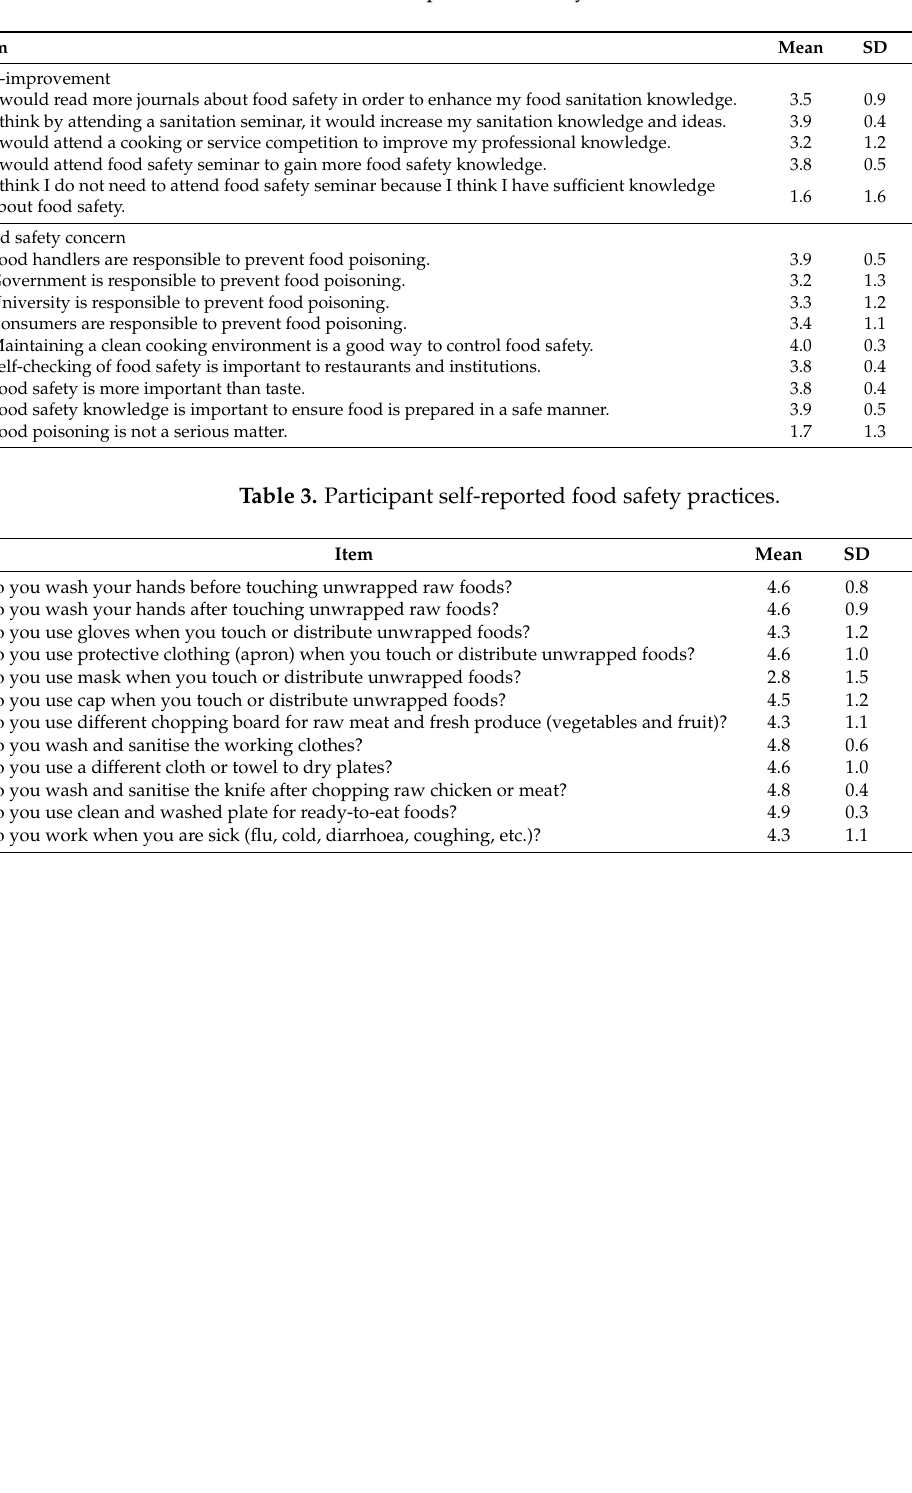
Table 2. Participant food safety attitude scores.